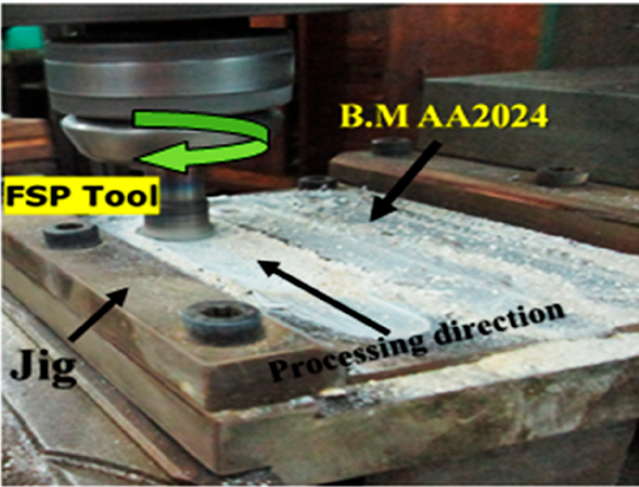
Figure 1. Friction stir processing (FSP) using an automatic vertical milling machine.